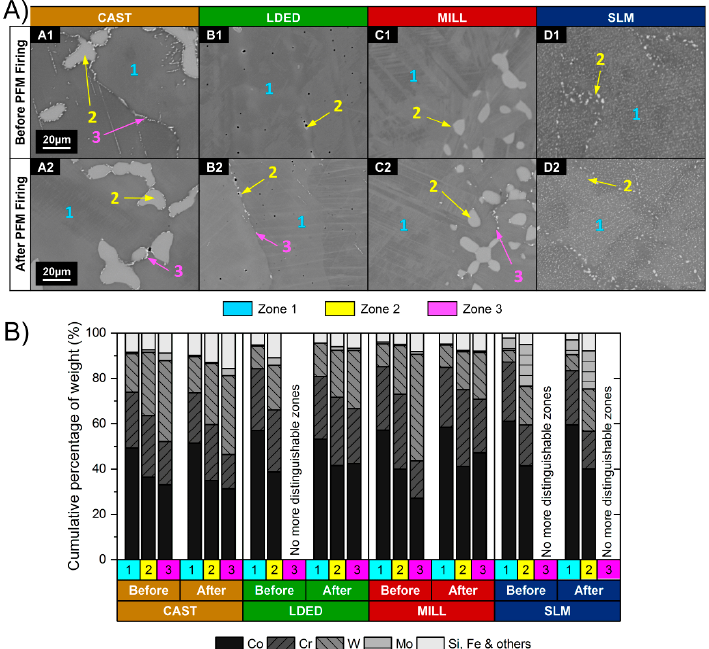
Figure 3. ( A ) Representative SEM micrographs of the segregation in each fabrication technique: CAST ( A1 , A2 ), LDED ( B1 , B2 ), MILL ( C1 , C2 ) and SLM ( D1 , D2 ). ( B ) Corresponding energy-dispersive X-ray spectroscopy (EDS) quantification analysis of the matrix 1 and segregation zones 2,3. All of it before and after PFM firing simulation.